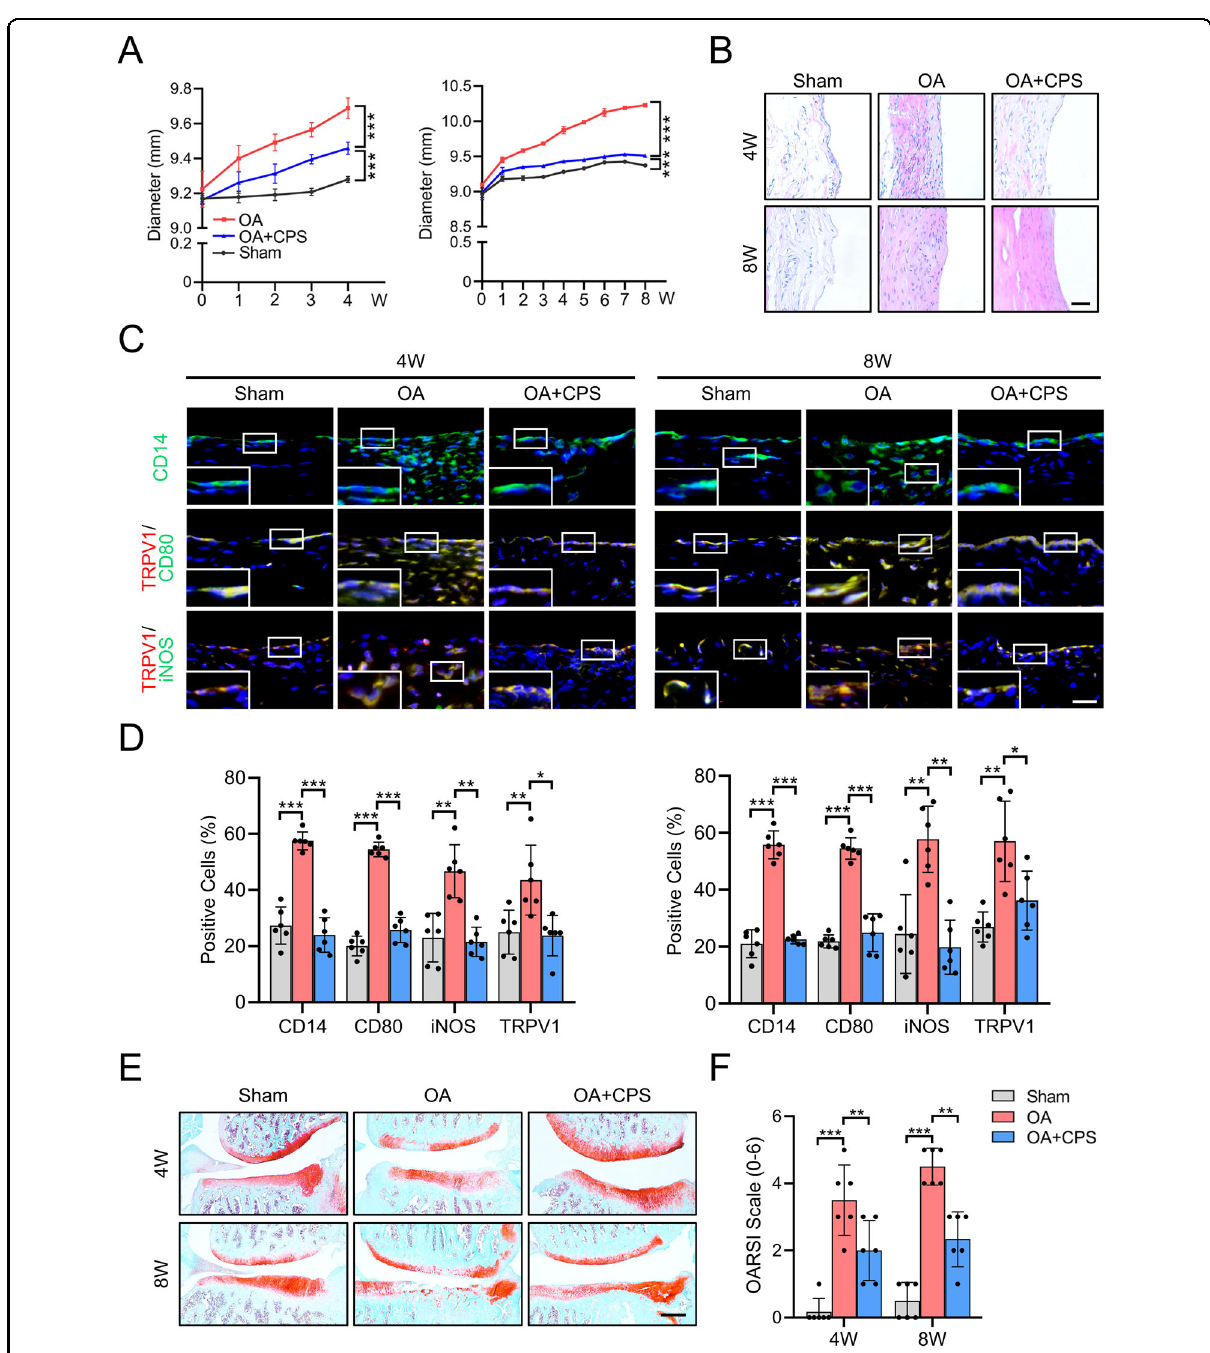
Fig. 2 TRPV1 alleviates OA by inhibiting M1 macrophage polarization in vivo. A Time course of rat knee joint diameter in the sham, OA, and OA + CPS groups until 4 (left) and 8 (right) weeks after the radial transection of the medial meniscus. B H&E staining of the synovium in the 4- and 8- week-old sham, OA, and OA + CPS groups. Scale bars: 100 μ m. C Immuno fl uorescence of CD14 and co-immunostaining of CD80 and iNOS with TRPV1 in the 4 and 8 weeks of sham, OA, and OA + CPS groups. Scale bars: 25 μ m. Enlarged image is in the boxed area in the bottom left corner. D Quanti fi cation of CD14-, CD80-, iNOS-, and TRPV1-positive cells as a proportion of total cells in the synovium of 4- (left panel) and 8- (right panel) week sham, OA, and OA + CPS groups. E SO staining of the knee joint of 4- and 8-week-old sham, OA, and OA + CPS groups. F Quantitative analysis of the OARSI scale of 4- and 8-week-old sham, OA, and OA + CPS groups. Data ( n = 6) are shown as mean ± SD. * P < 0.05; ** P < 0.01; *** P < 0.001. W week, SO Safranin O/fast